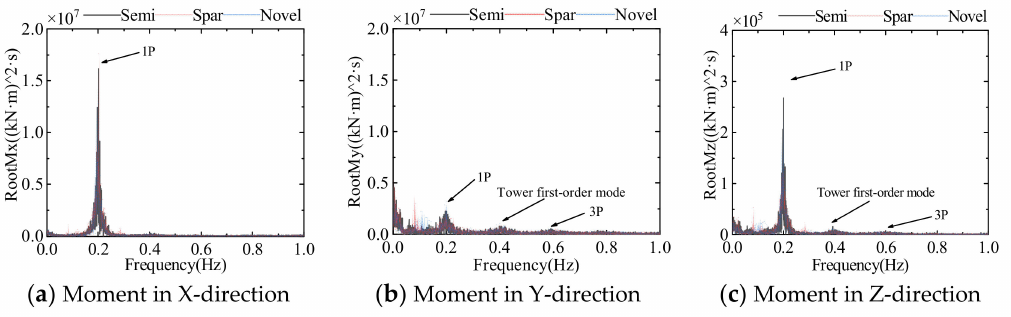
Figure 28. Power spectral density of blade root moment of three